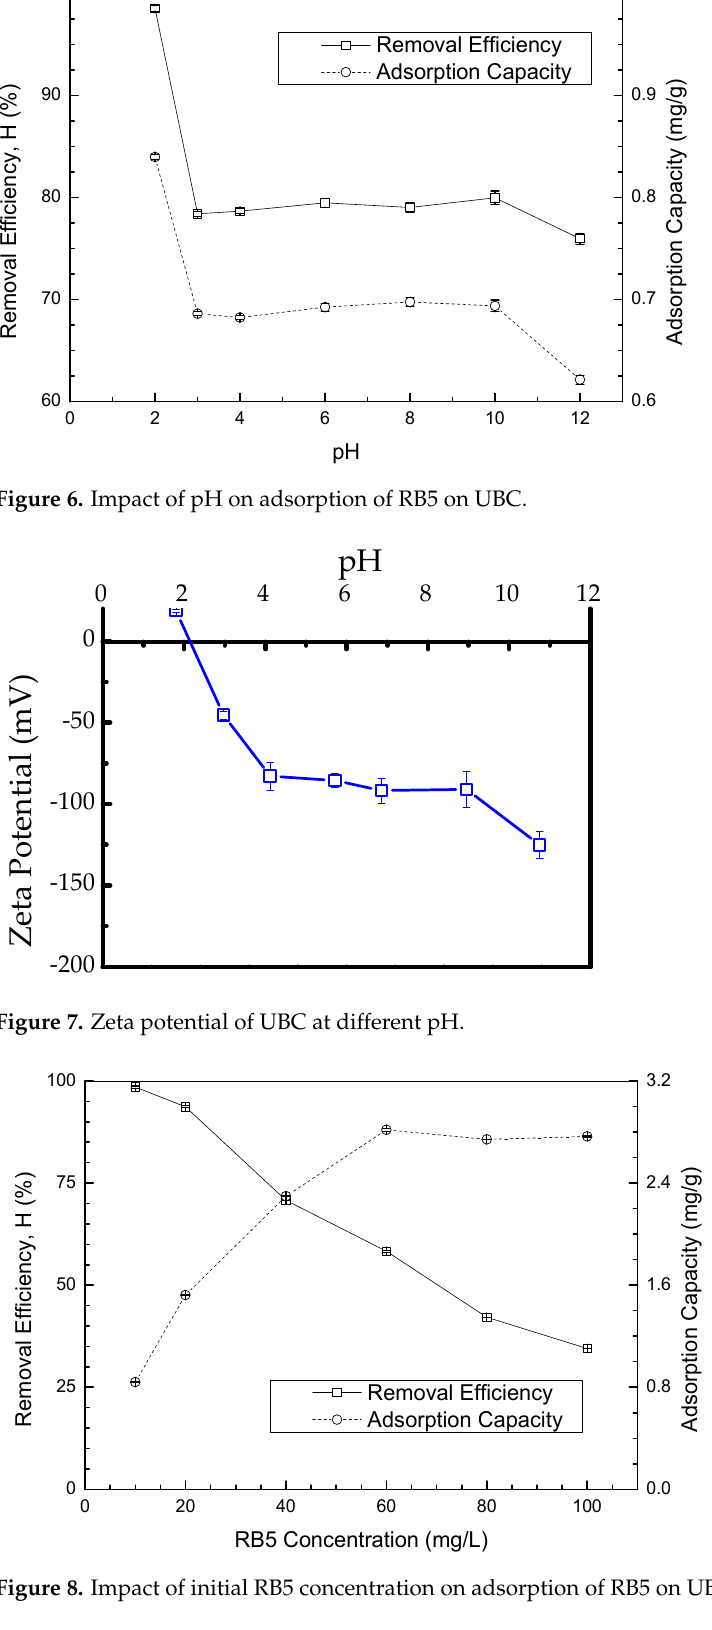
Figure 8. Impact of initial RB5 concentration on adsorption of RB5 on UBC.